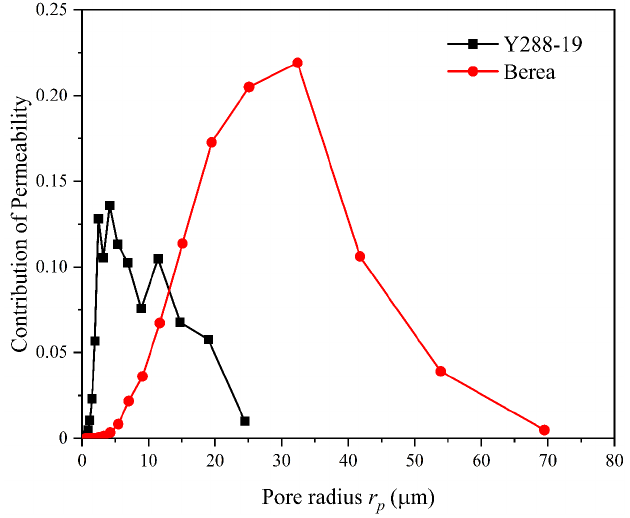
Figure 9. Pore radius distribution and absolute permeability contribution curve of two types of cores.